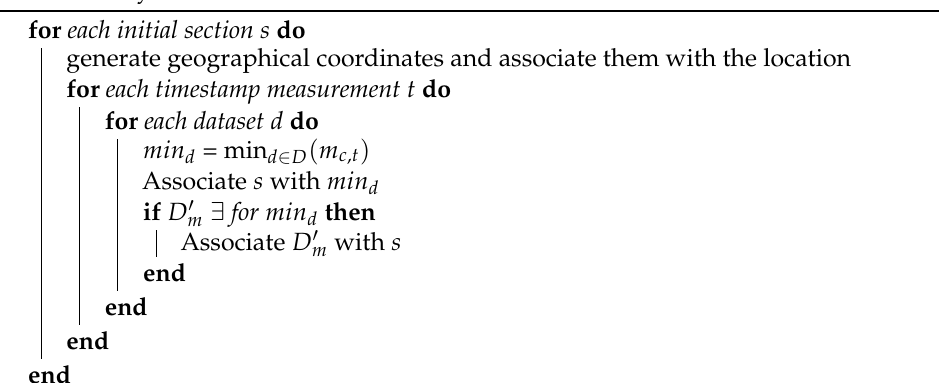
Algorithm 1: The methodology for associating initial geographical values in time with asynchronous measurements and additional